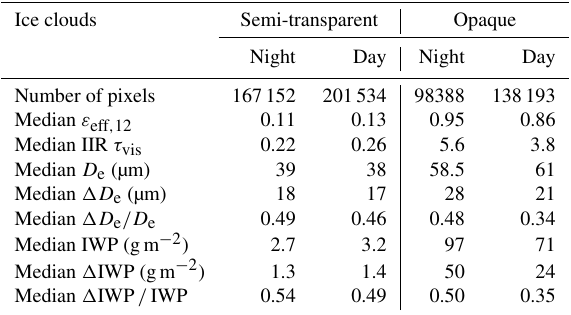
Table 4. Statistics associated with V4 effective diameter ( D e ) and ice water path (IWP) retrievals in single-layered ice clouds between 60 ◦ S and 60 ◦ N over oceans in January 2008 (see Fig.